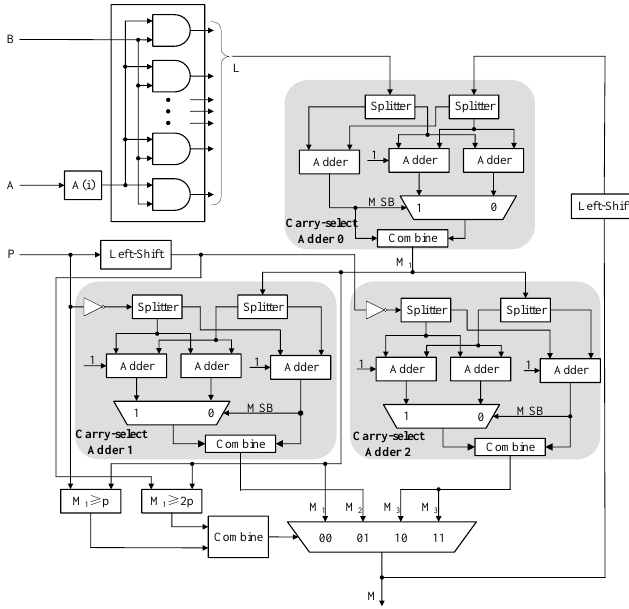
Figure 1. Architecture of proposed modular